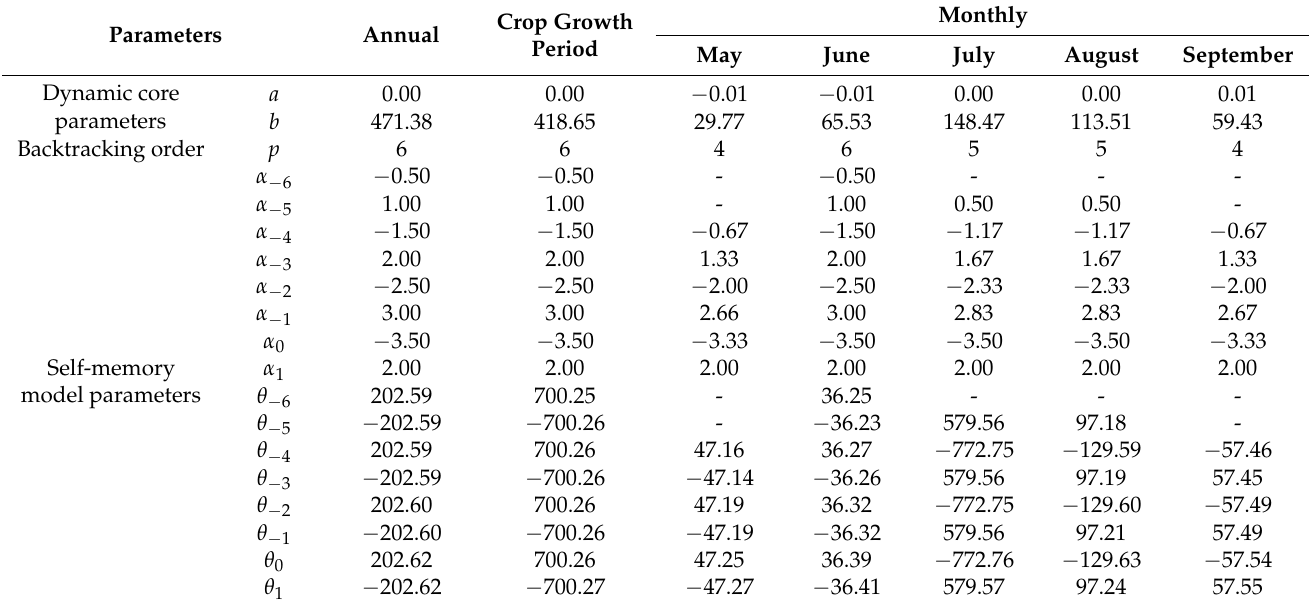
Table 2. Parameters of the MGSM at different precipitation